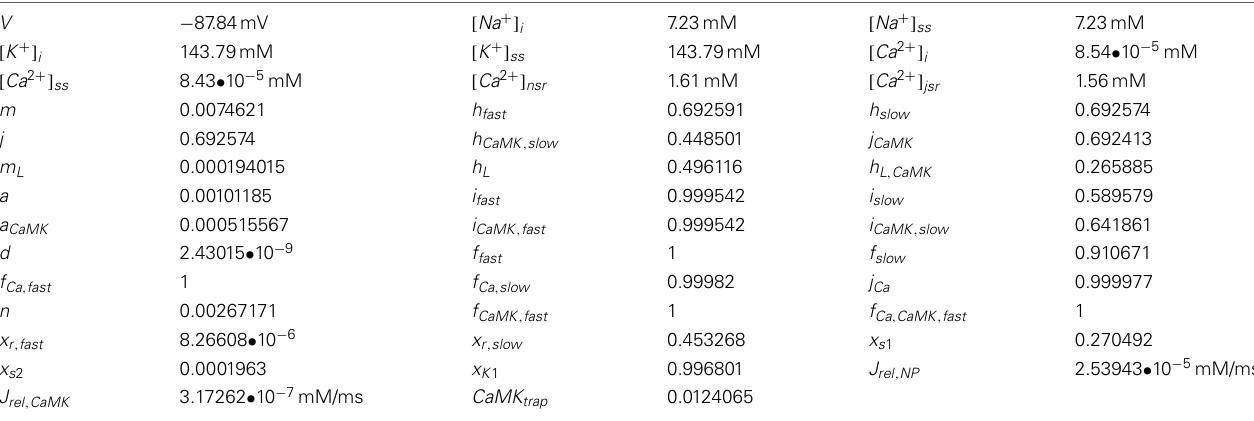
Table 1 | Initial conditions for state variables in human ventricular ionic